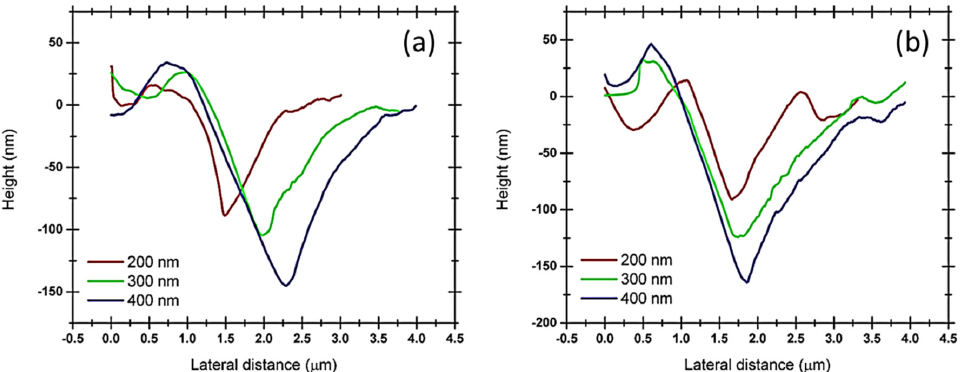
Figure 8. Height profiles obtained through SPM along the major axis of the Berkovich tip for both the RD and TD of Cu(16)/Nb(16) ARB nanolaminate, which were later used for measuring pile-up heights with respect to nanoindentation depth along the ( a ) TD and ( b ) RD of Cu(16)/Nb(16) ARB nanolaminate.